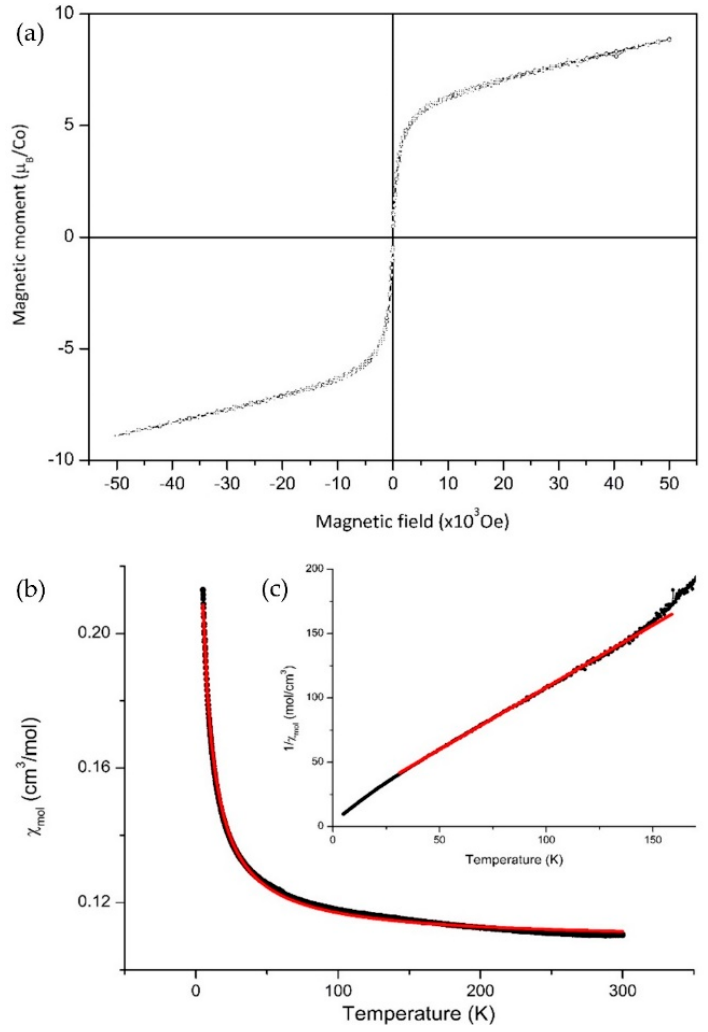
Figure 4. SrLi 2 {Li 0.65 Co 0.35 [Co 0.65 Li 0.35 N 2 ]}: ( a ) Hysteresis of the magnetic moment against varying intensity of a magnetic field at 300 K; ( b ) Magnetic susceptibility per mol, with varying temperature at 10 kOe (black) and a fitted Curie-Weiss law curve (red); ( c ) Inverse magnetic susceptibility per mol with varying temperature at 10 kOe (black) and a fitted inverse Curie-Weiss law line between 40 and 150 K